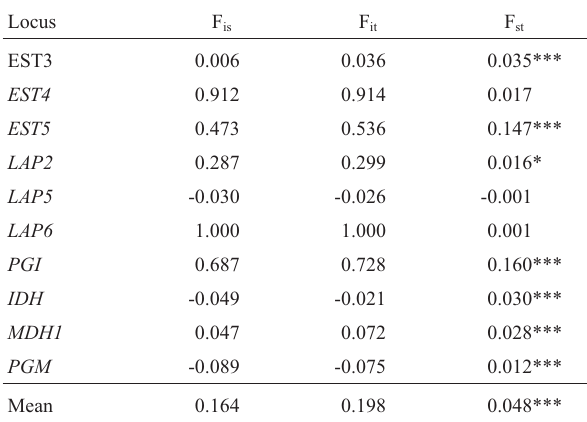
Table 3 - Genetic structure analysis of Aedes aegypti populations from Manaus, using Wright’s F statistics. Locus